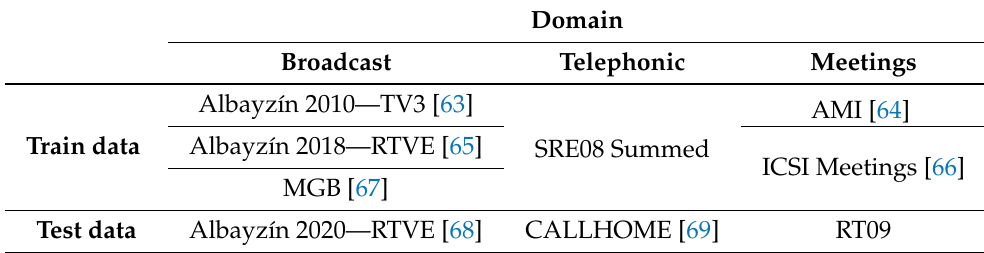
Table 1. Data description for baseline SAD